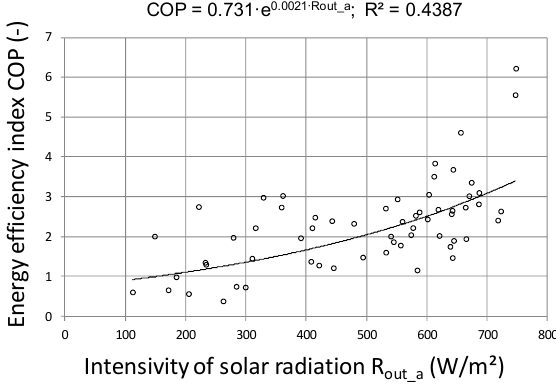
Figure 26. Energy efficiency of heat storage depending on the solar radiation flux. Figure 26. Energy e ffi ciency of heat storage depending on the solar radiation